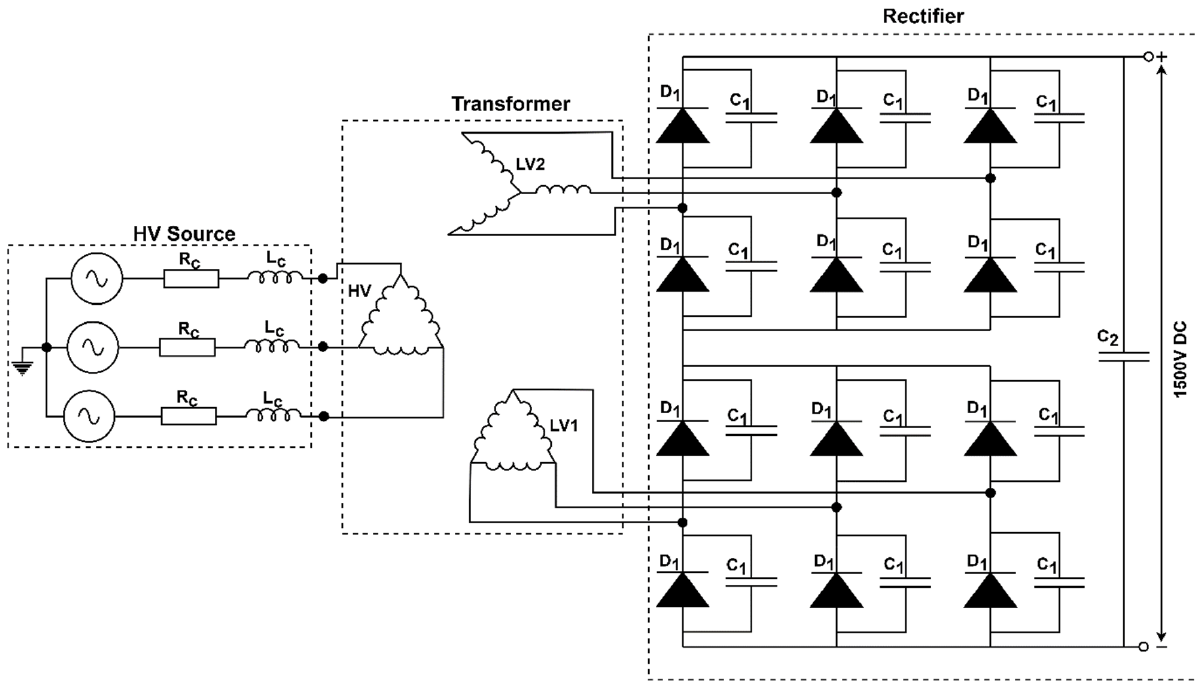
Figure 4. HV source and transformer rectifier modeled in MATLAB/Simulink. Table 3. Rectifier input parameters [24].